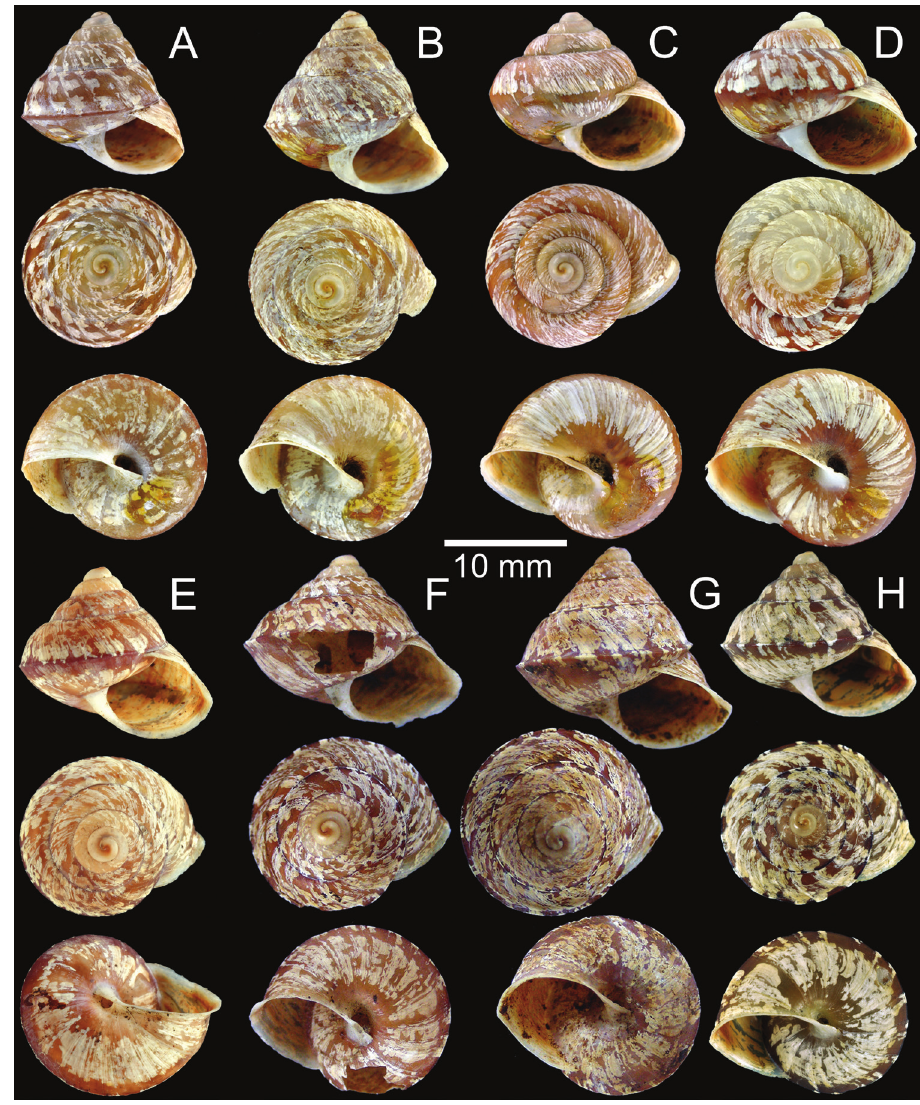
Figure 2. A, B Ganesella capitium A lectotype UMZC I.102385/1 and B paralectotype UMZC I.102385/2–3 C–E Ganesella hariola C lectotype UMZC I.104370/1 D paralectotype UMZC I.104370/2–4 and E shell from Popa Mountain, Myanmar CUMZ 5134 F–H Ganesella carinella F lecto- type SMF 27534a G paralectotype SMF 27534b and H shell from Takhli, Nakhonsawan CUMZ Pallial system. Typical sigmurethran; heart (au and ve) located left of kidney (on right in Fig. 5C). Pulmonary cavity approximately 5× longer than wide. Pulmonary vein (puv) and venation on lung roof (l) distinct and well developed. Kidney (k) long, slender and extending from posterior side to approximately the middle of pulmonary